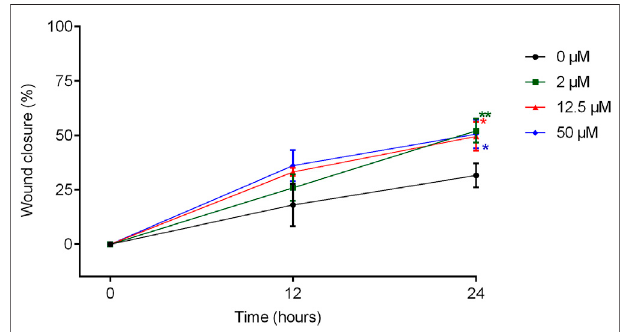
FIGURE 7 | Cell migration of 3T3 cells treated with TanP after the Scratch assay. Fibroblast con fl uence after scratching and treatment with different concentrations of TanP (0 – 50 µM) was analyzed at 0, 12, and 24 h. The areas weremeasuredwiththe aidofthesoftware NIS-ElementsAR. Statistical signi fi cance was performed using ANOVA followed by Tukey ’ s test andexpressed asmean ± SD(n (cid:2) 3). *p < 0.05and **p < 0.01,compared with the control group (without